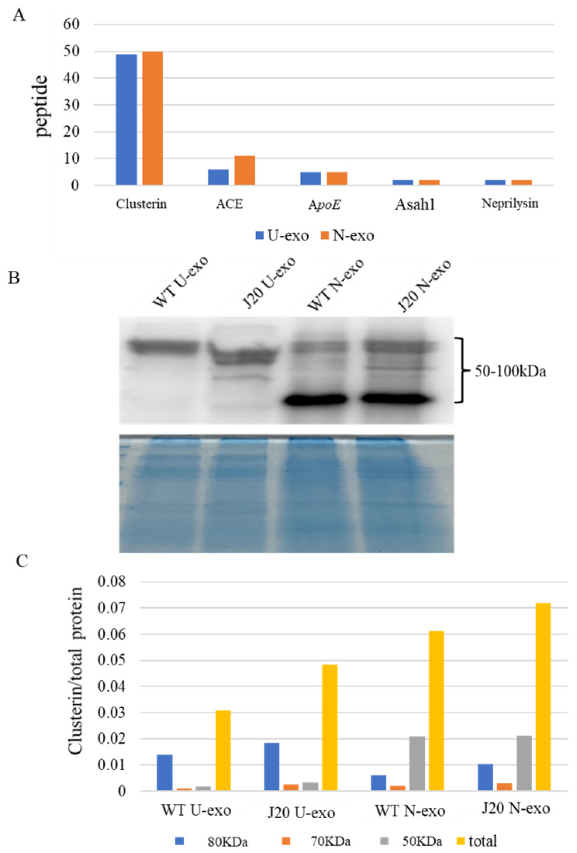
Figure 9. Validation of the most important protein. ( A ) Comparison of the number of distinct peptides with at least 95% confidence among screened important proteins in the early stages of AD pathology. ( B ) Western blotting for clusterin. The total protein stained by Coomassie brilliant blue (CBB) was used as loading control. ( C ) Relative levels of clusterin among groups. Clusterin was normalized by the total protein stained by CBB. U-exo: urine exosomes. N-exo: neuron-derived